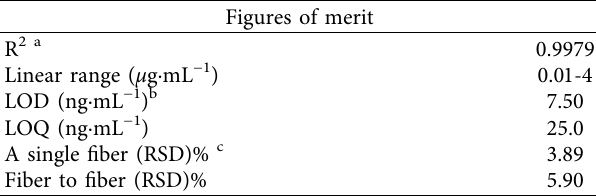
Table 1: Analytical characteristics of the proposed method Figures of merit